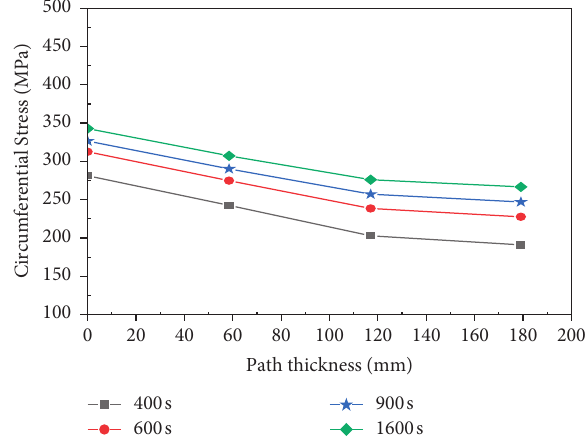
Figure 10: Circumferential stress variation along the inlet nozzle- inside vessel wall intersection thickness of the FE model.